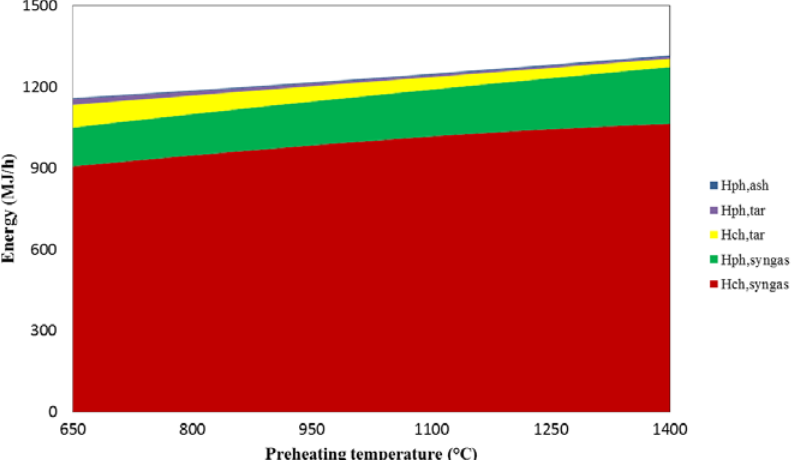
Figure 6. Energy balance of the HTAG process as a function of preheating temperature for S/B =